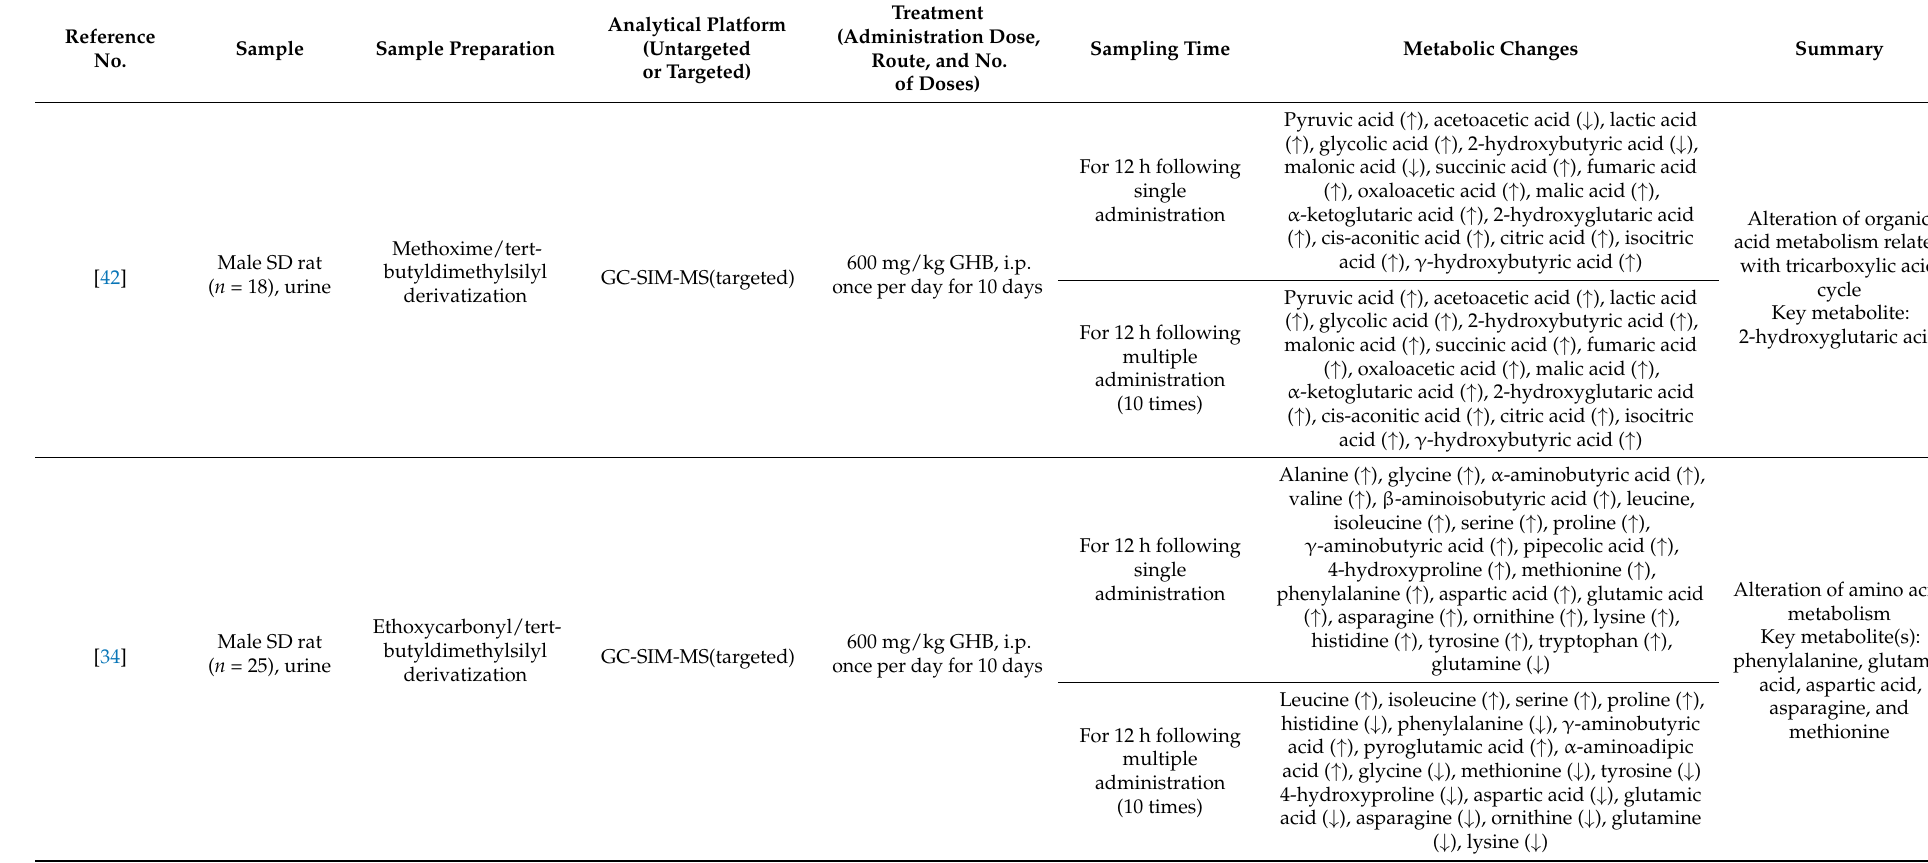
Table 1. Summary of metabolic changes in organic acids, amino acids, and polyamines following GHB exposure. Reference